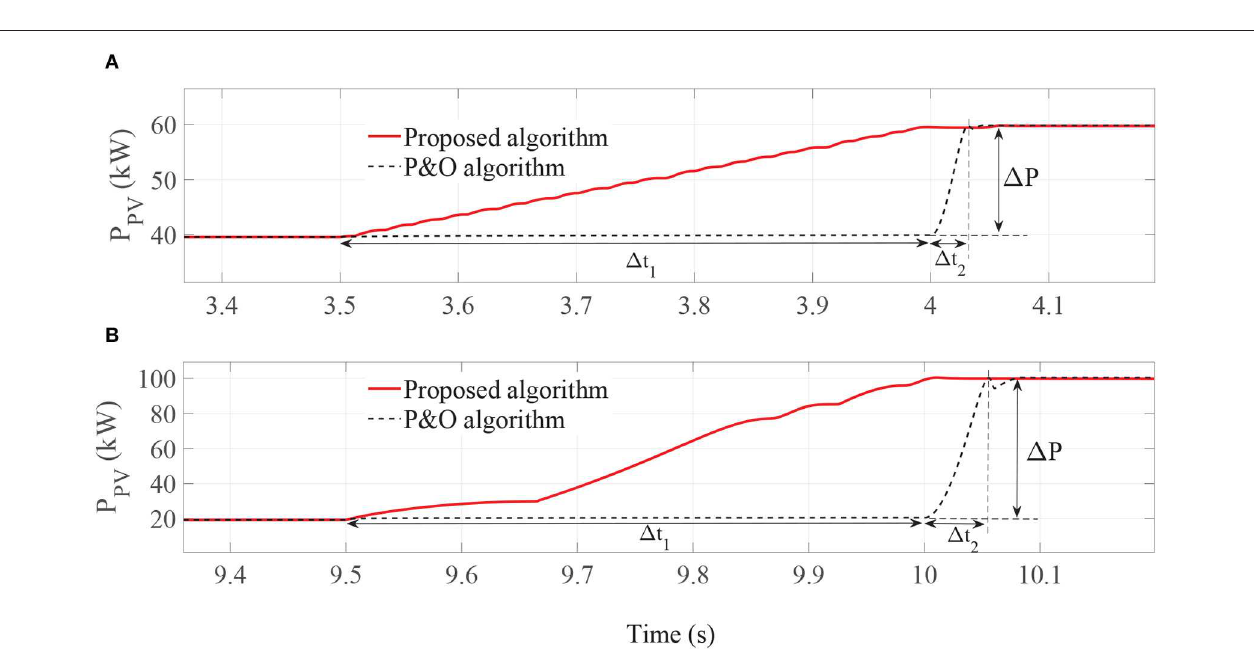
keeping temperature constant at 25 o C or 50 o C. As illustrated in Figure 7B , the solar irradiation increases from 200W/m 2 at t = 1 s up to 1, 000W/m 2 at t = 9 s and changes in the opposite direction between t = 11 s and t = 19